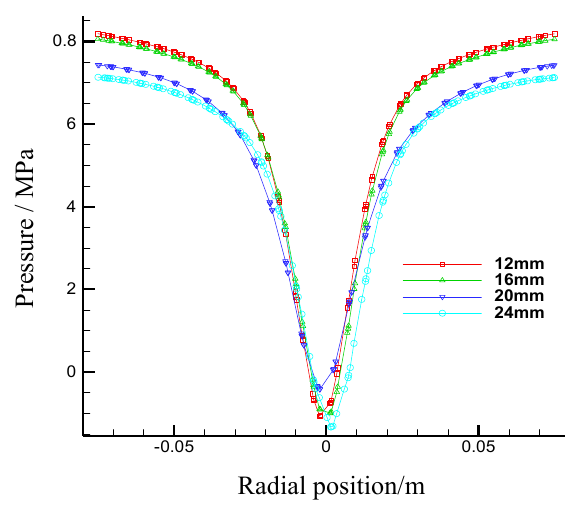
Figure 17. Pressure distribution inside cyclone with different I underflow pipe.